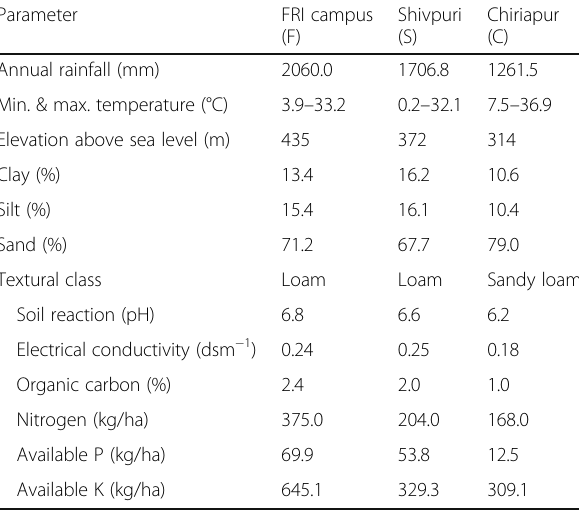
Table 1 Climatic conditions and physico-chemical properties of soils of different